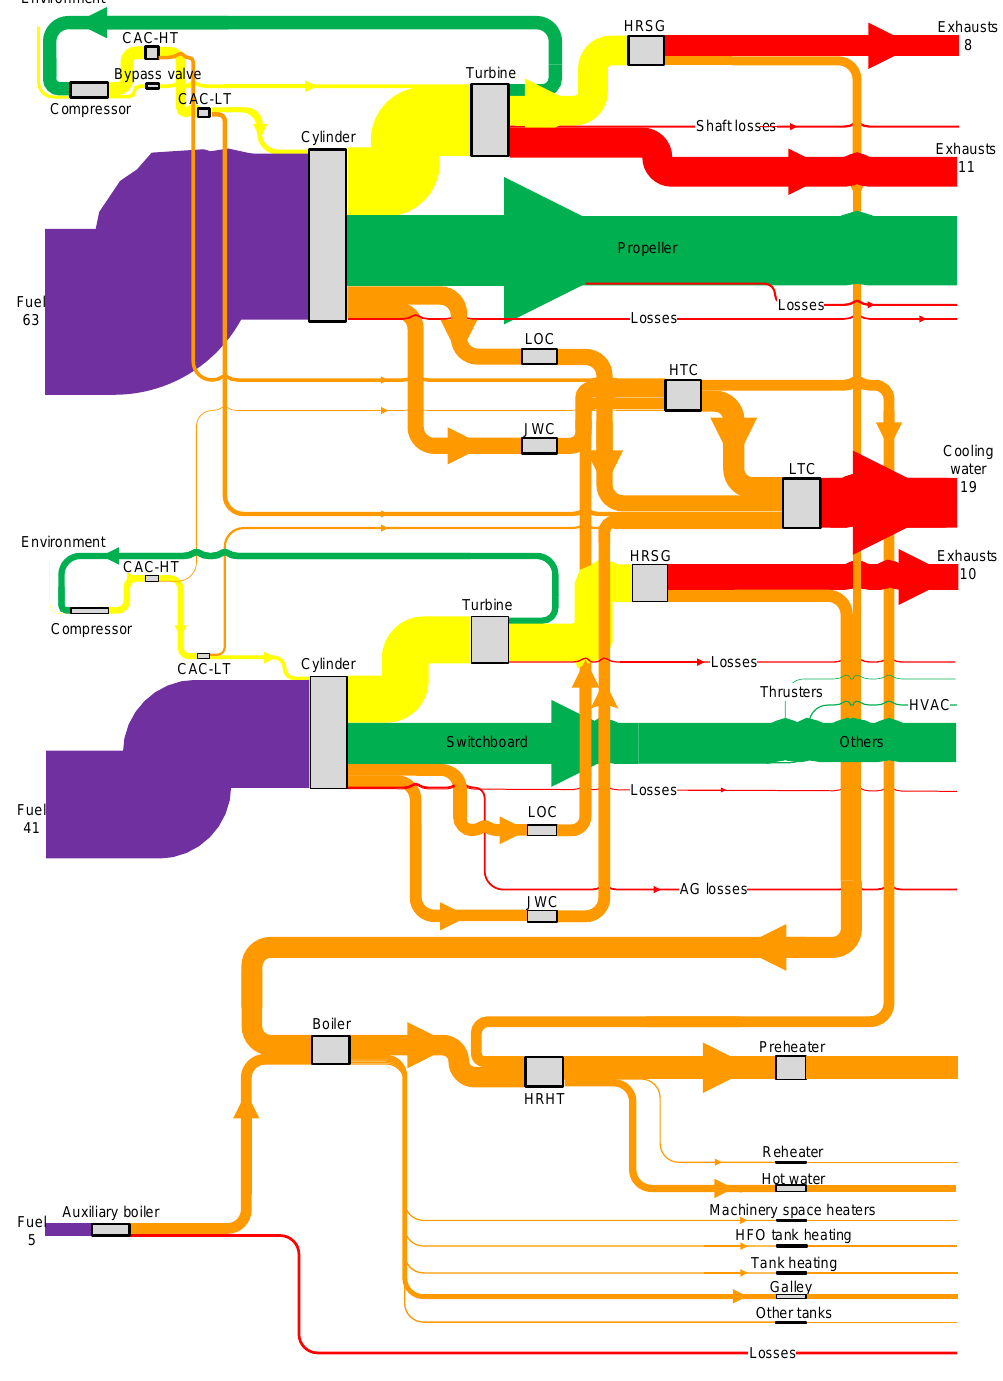
Figure 17. Sankey diagram. The purple color refers to chemical energy; the green color refers to electric/mechanical energy. The yellow color refers to the exergy in the exhaust gas; the orange color refers to the energy in the cooling flows; the red color refers to the energy losses. Flow values are in